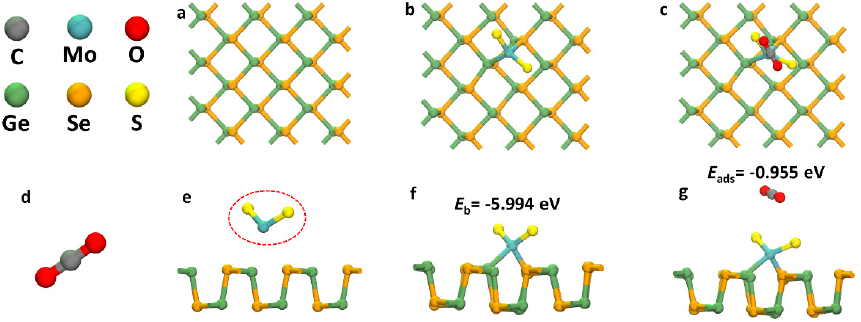
Figure 1. Geometric structures of the GeSe monolayer ( a , e ), the MoS 2 –GeSe monolayer ( b , f ), the CO 2 /MoS 2 –GeSe monolayer ( c , g ) and CO 2 ( d ). The red circle is MoS 2